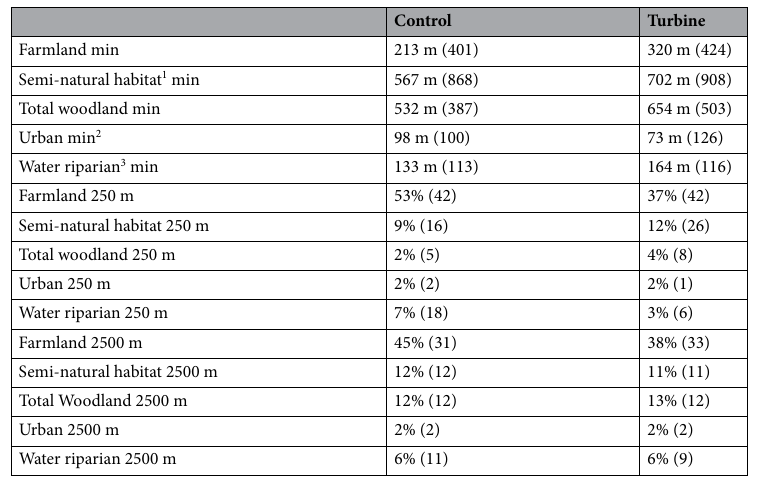
Table 2. Summary of landscape metrics—the mean and SD for the minimum distance to broad habitats and percentage cover of broad habitats within 250 m and 2500 m of the paired turbine and control locations across 23 wind farm sites. Habitat data were extracted from Land Cover Map 2007 30 ; the urban statistics were extracted from OS Mastermap 31 . 1 Rough grassland and scrub, 2 buildings, structures, and roads, 3 inland water, coastal water, bog, fen, marsh, and